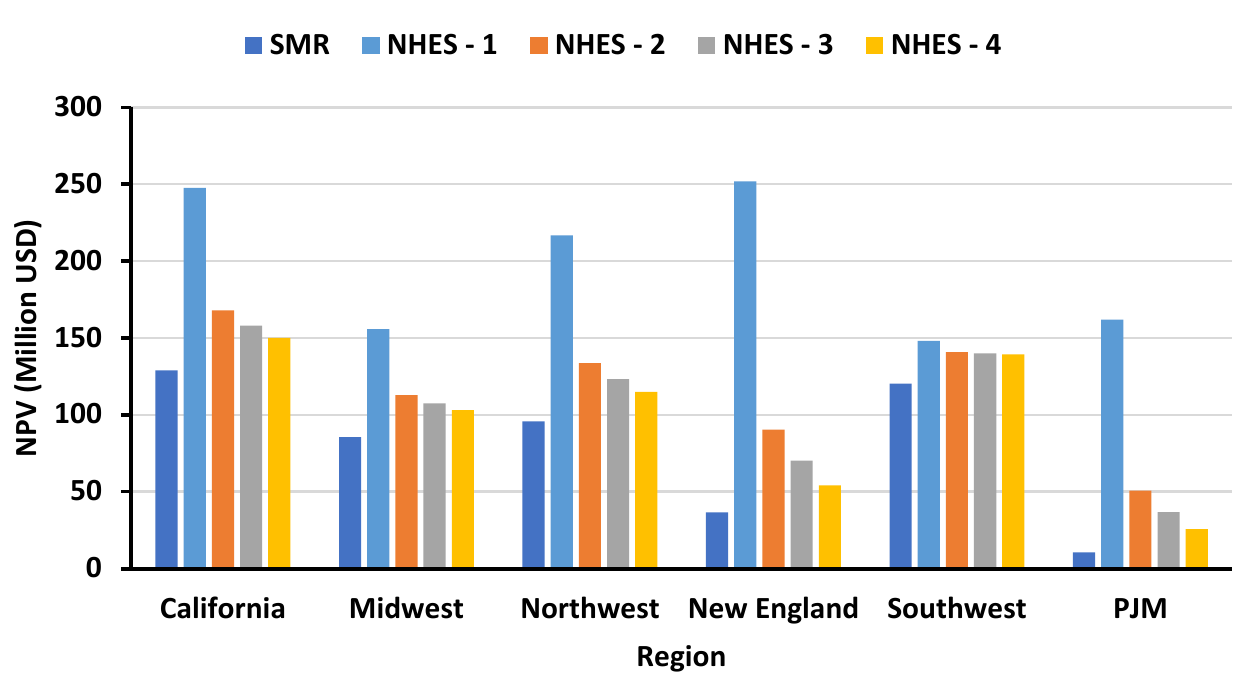
Figure 7. NPV values at different regions for SMR and different SMR-ChHP output scenarios.